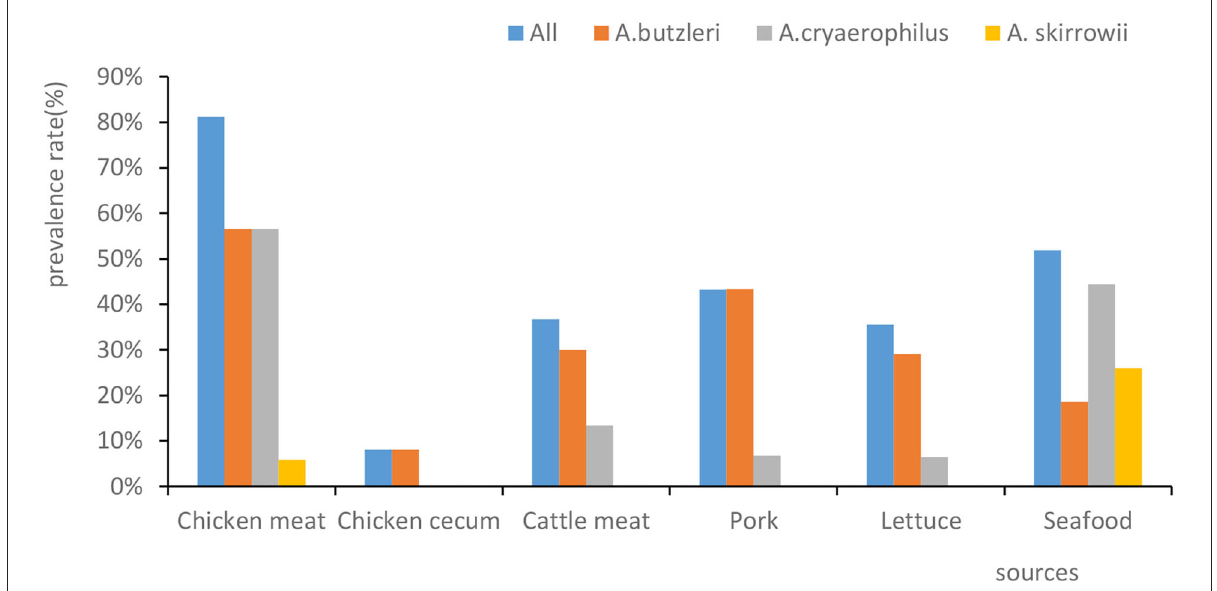
FIGURE1 The prevalence rates of Arcobacter spp. isolated from different sources. The x -axis represents the sources. The y -axis represents the prevalence percentage. The color of the columns corresponds to the organisms.